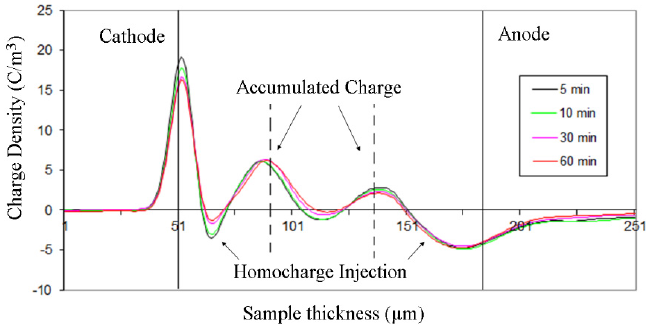
Figure 16. Space charge behaviour of oil ‐ paper insulation with three layers under Volt ‐ off condition.